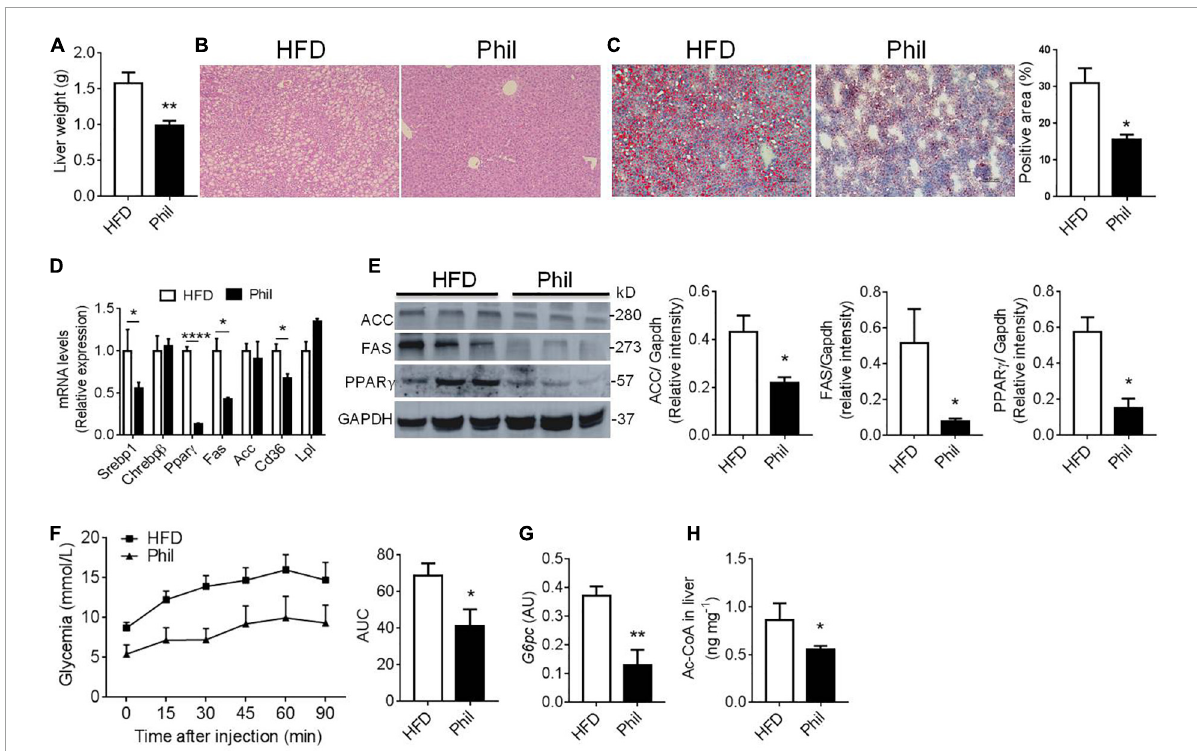
FIGURE3 Phillyrin treatment alleviates hepatic lipid accumulation. (A) Total liver weight of HFD-fed mice gavaged with vehicle or with 25 mg per kg body weight Phillyrin. N = 4–5 per group. (B) Representative images of hematoxylin-eosin stained livers in the groups indicated. Magnification × 100. Scale bars, 100 µ m. N = 3 per group. (C) Representative images of oil red O stained liver tissues (magnification × 100) and quantification of the staining in the groups indicated. N = 3 per group. (D) Expression of lipid metabolism related genes in the livers of mice in each group. N = 3–4 per group. (E) Protein levels of FAS, ACC, and PPAR γ were detected in the livers. N = 3 per group. (F) Pyruvate tolerance test was determined after 2 months of drug intervention by i.p. injection of 2 g per kg body weight of pyruvate in mice in indicated groups. Area under the curve (AUC) was calculated using GraphPad Prism software. N = 5–6 per group. (G) mRNA level of G6pc in the livers of mice in each group. N = 4–5 per group. (H) Contents of acetyl-CoA in the liver in the groups indicated. N = 6 per group. All data in the figure are presented as mean ± SEM. * P < 0.05, ** P < 0.01, and **** P <